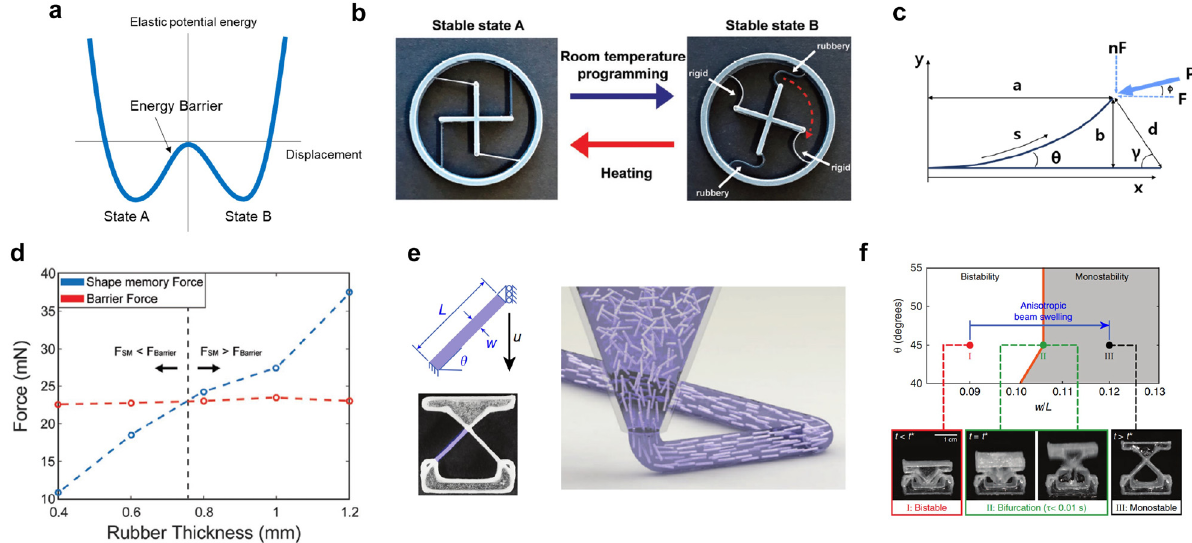
Figure 3: 4D-printed bistable structures. (a) Elastic potential energy diagram of a bistable structure. (b) Thermal actuation of the rotational bistable structure. (c) Schematic for